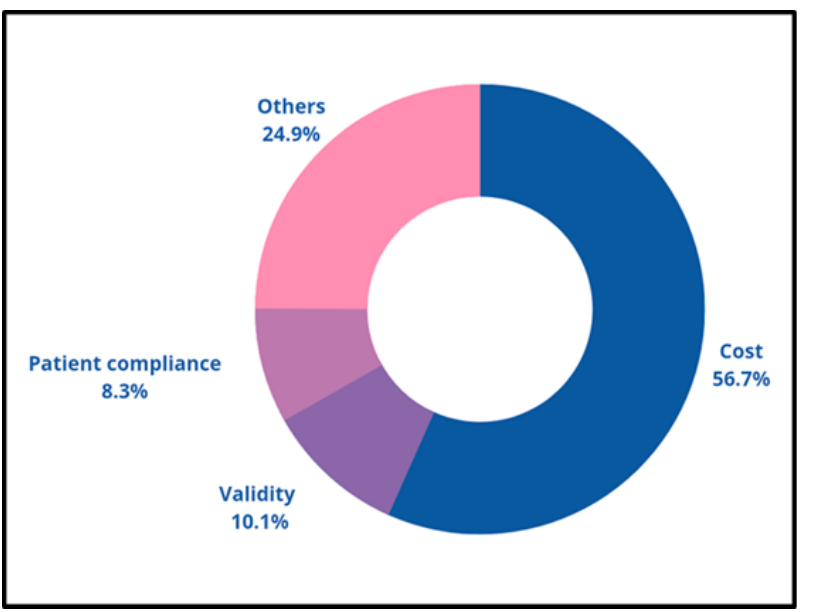
Figure 4. Diagrammatic representation for major limitations concerning the user compliance and ergonomics.